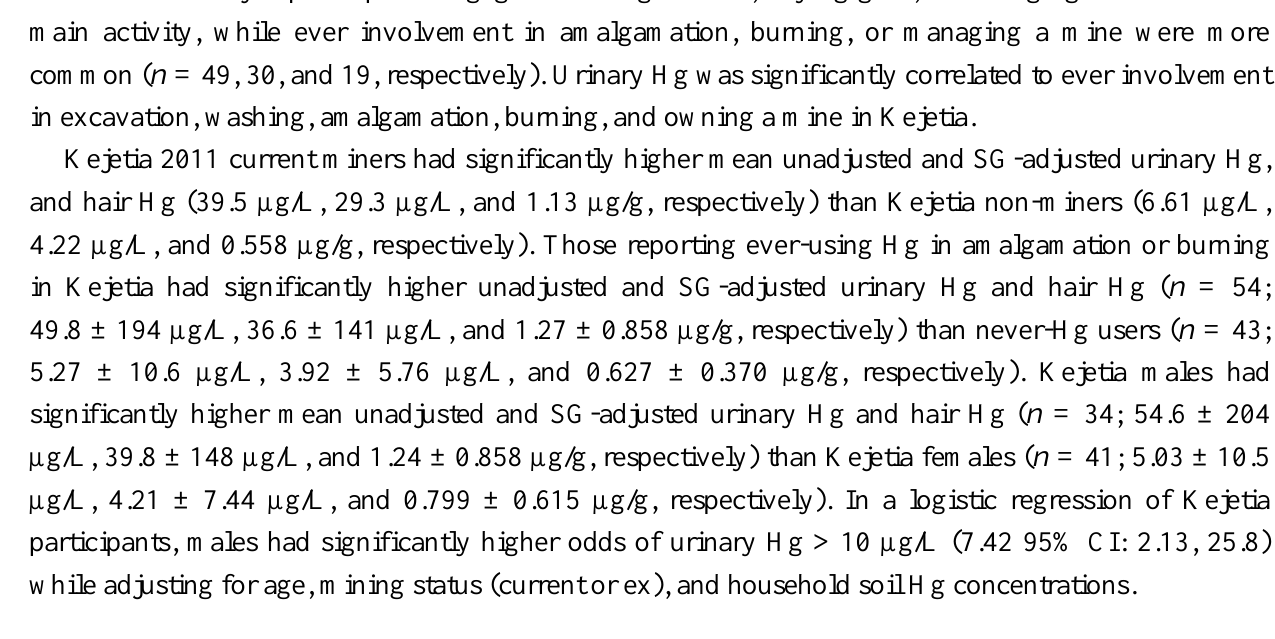
Table 2. Biomarkers and household soil Hg concentrations for all